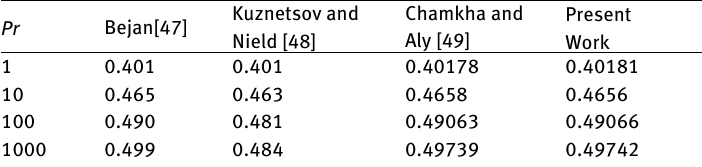
Table 1: Comparison of the Nusselt number for various values of Pr with Le=10, N=Nb=Nt=10 −5 , S f =0, S T =0 and M =0